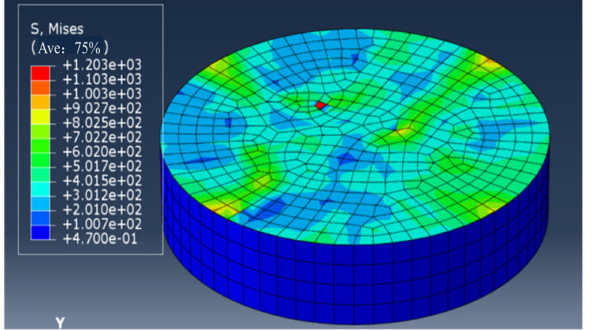
Figure 7. Mises stress distribution in the interface when the interface was applied 7 N tensile force at four